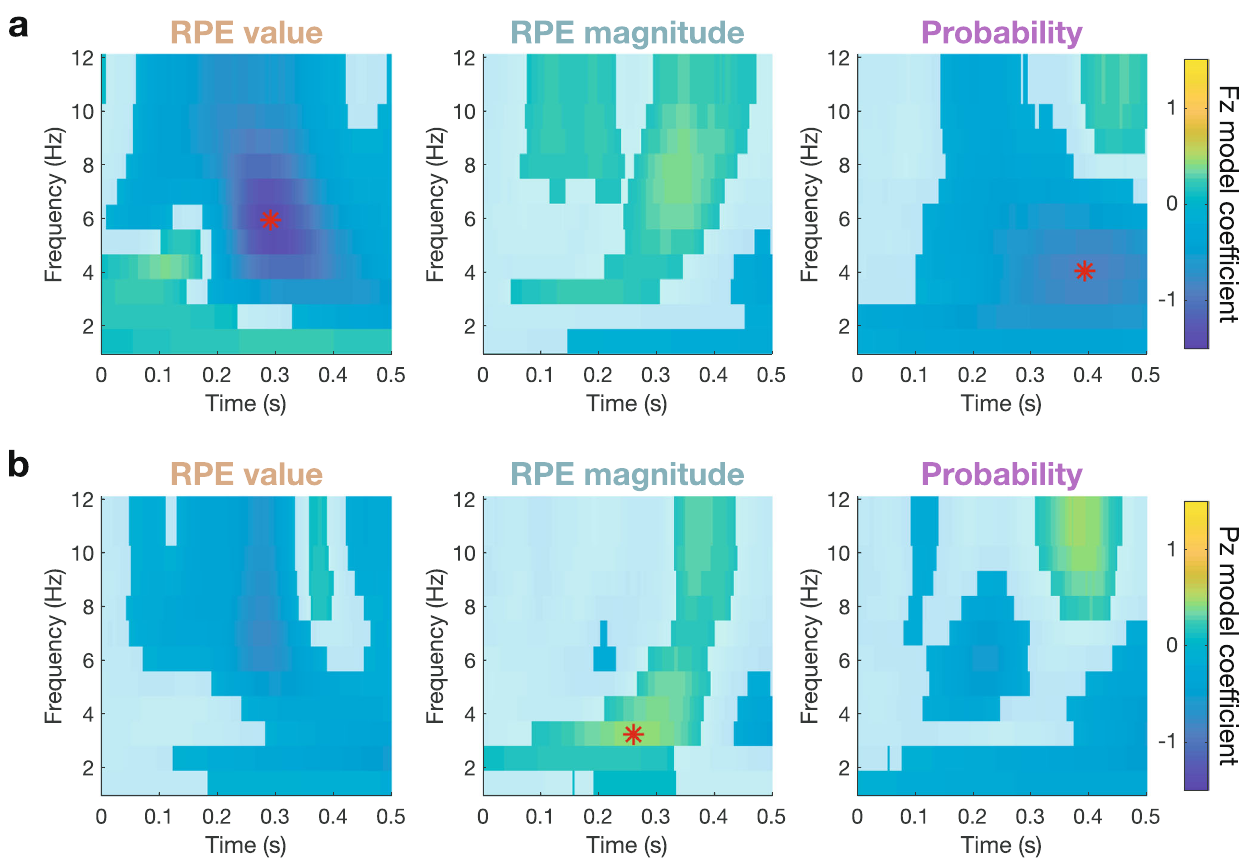
Fig. 4 Time-frequency power signatures of prediction errors. a Model coef fi cients fi t to evoked power at each time-frequency point for frontal electrode Fz, with nonsigni fi cant points ( q FDR > 0.05; n = 32 participants) plotted opaquely. Red stars indicate maximal coef fi cients for each model predictor across both electrodes. Valenced RPE value coef fi cients peak in frontal theta power, and non-valenced probability coef fi cients peak later in frontal delta power. b Same for Pz. Non-valenced RPE magnitude coef fi cients peak in posterior delta